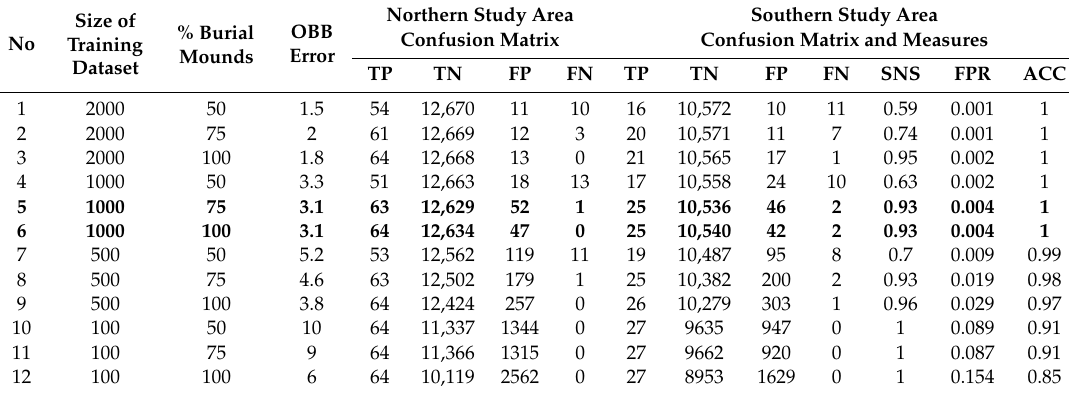
Figure 10. The plot of OOB error showing the mtry and node size tuning with 100 ntree. (a high-resolution version can be found at https://doi.org/10.6084/m9.figshare.11798661) Table 1. The Random Forest (RF) model parameters and the confusion matrix of the validation